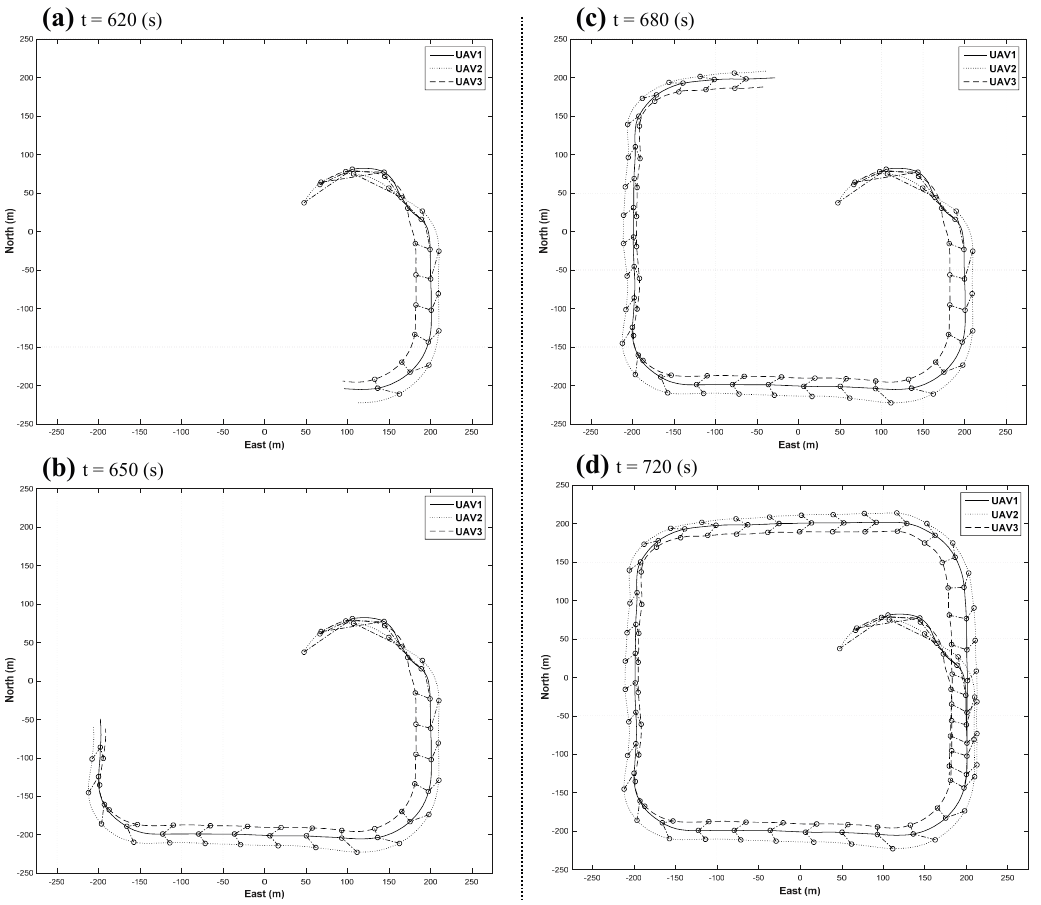
Figure 18. Detailed sequences of close triangular formation